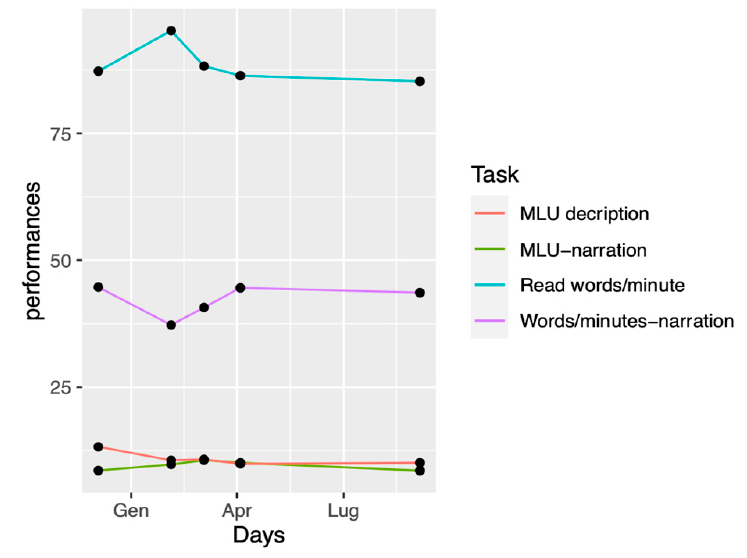
Figure 3. MLU and words/minute reading performances.